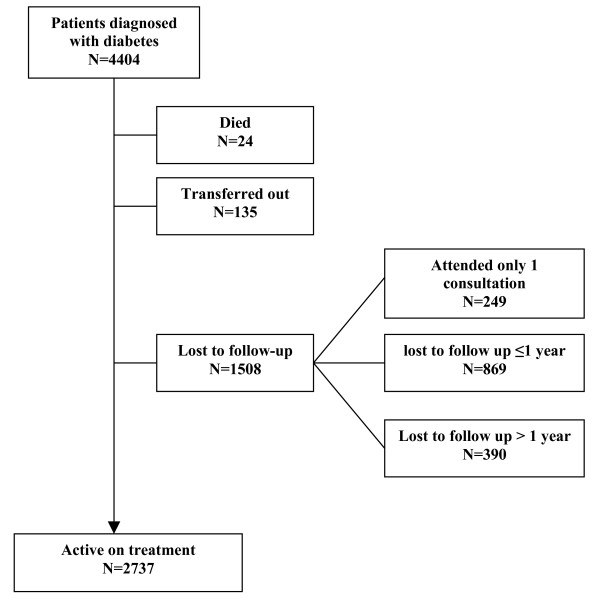
Outcome of diabetic patients diagnosed in 2002 to 2008 at end of study period (June 2008).